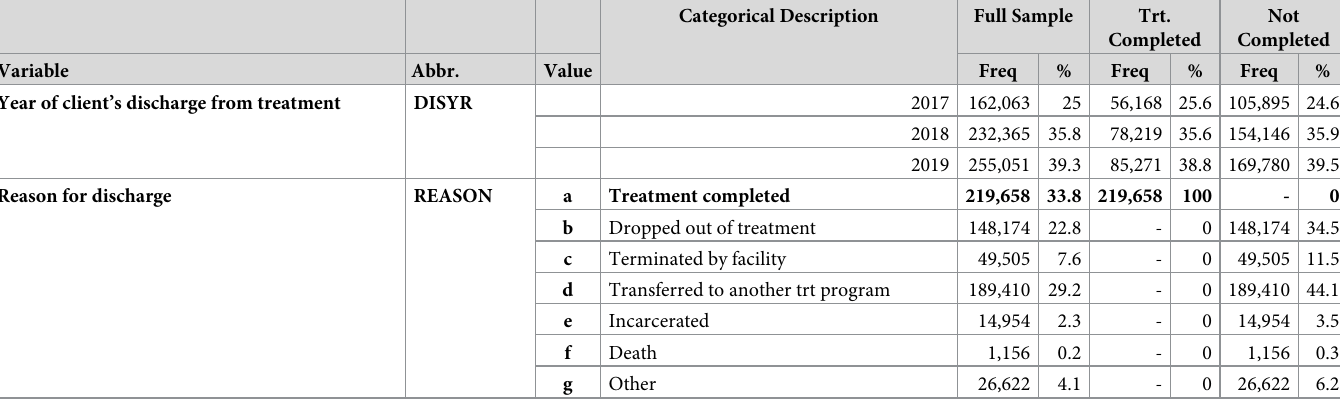
Table 1. TEDS-D sample description (2017–2019) including differences for substance use disorder treatment completed vs. not completed subgroups.